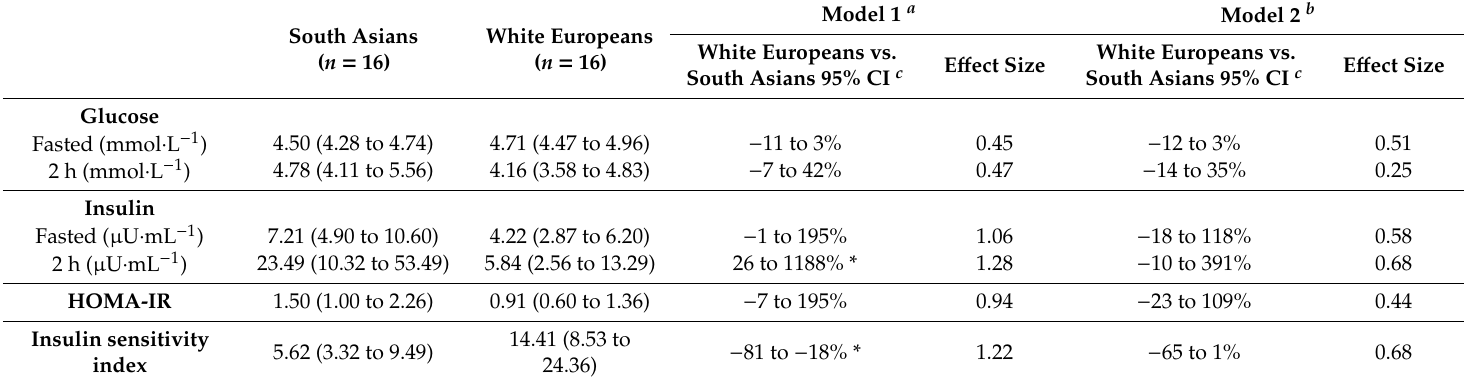
Table 4. Plasma glucose and insulin concentrations during the OGTT in South Asian and white European